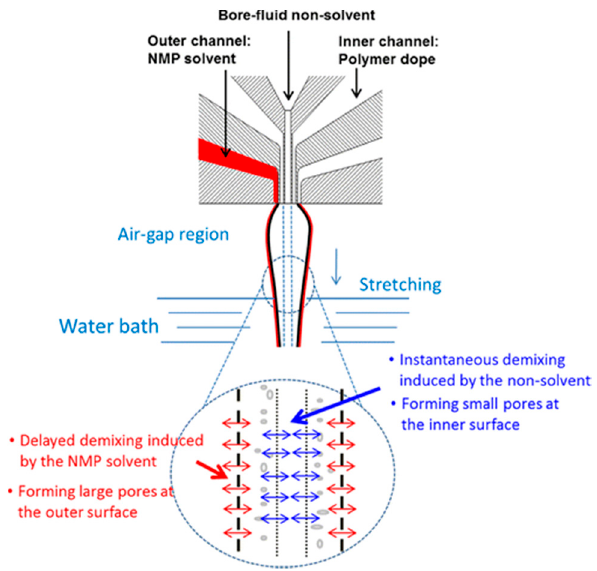
Figure 6. Strategies to control the phase inversion process with the aid of coextrusion technology employing a dual-layer spinneret [28].